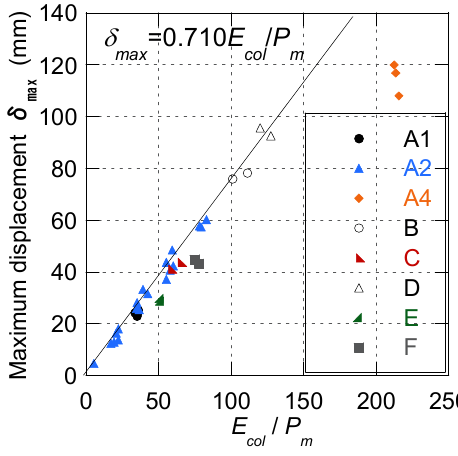
Fig. 11. Maximum displacements depending on